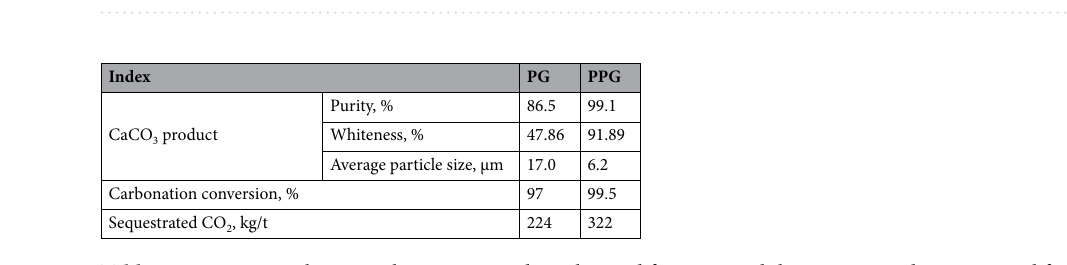
Figure 6. A SEM photograph and the XRD pattern of the CaCO 3 product obtained from PPG through mineral carbonation.